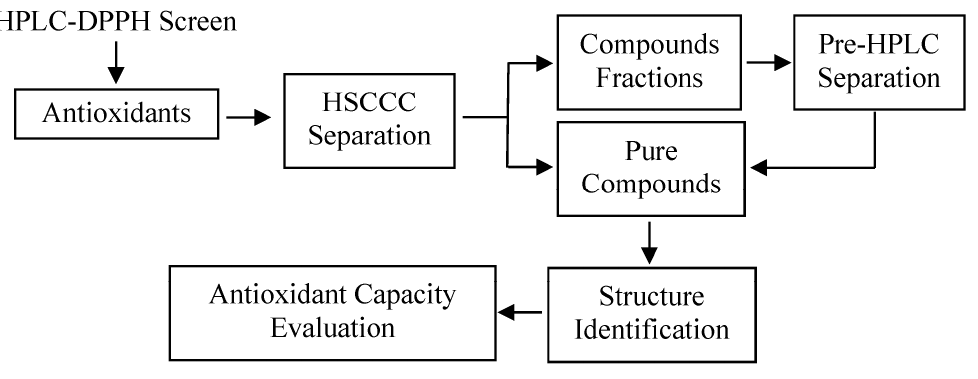
Figure 6. The diagram of the procedure.